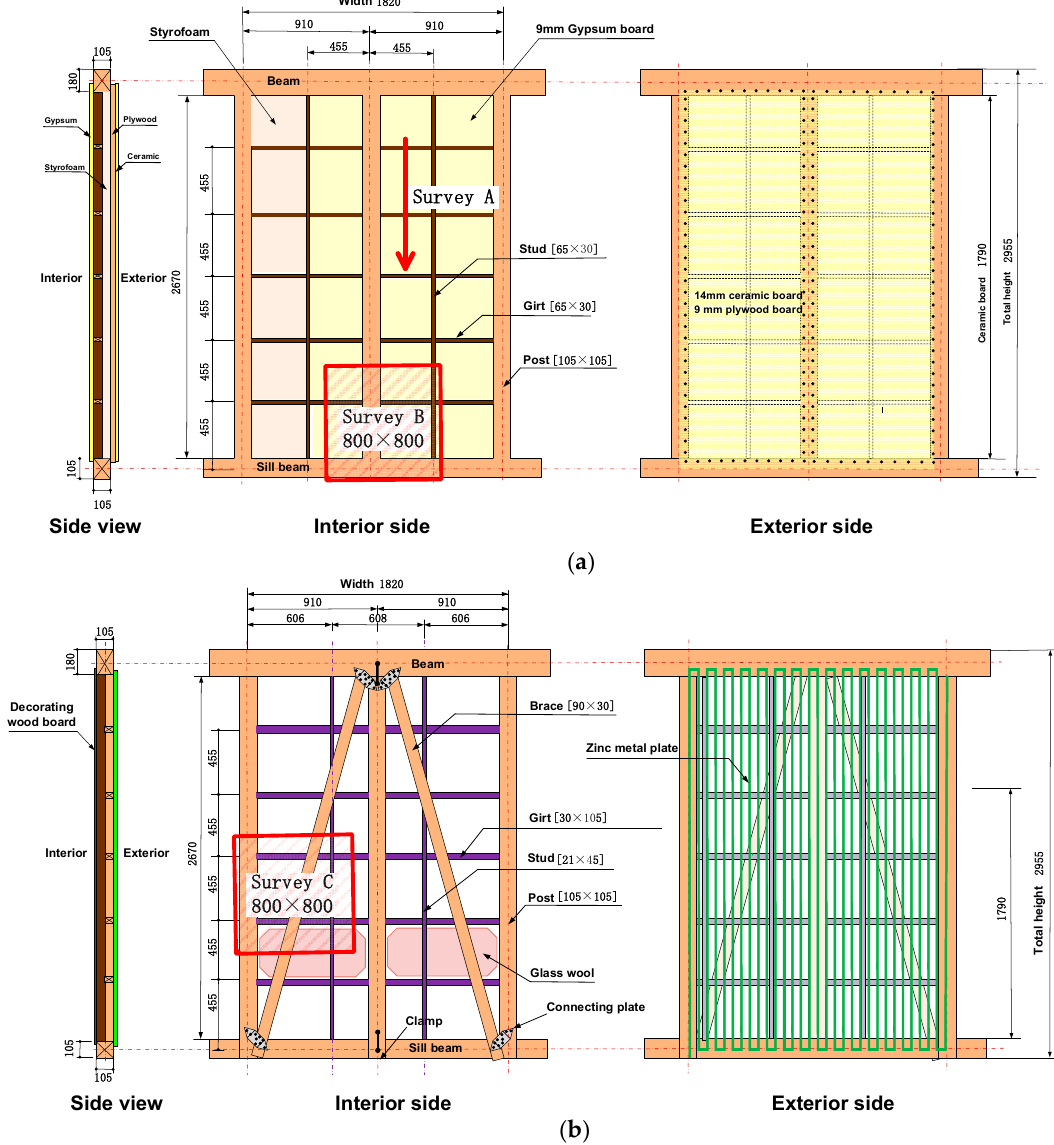
Figure 1. Designs of sample wooden walls. ( a ) Type I; ( b ) Type II. One survey line and two survey areas are marked by red color. The unit is in millimeter.